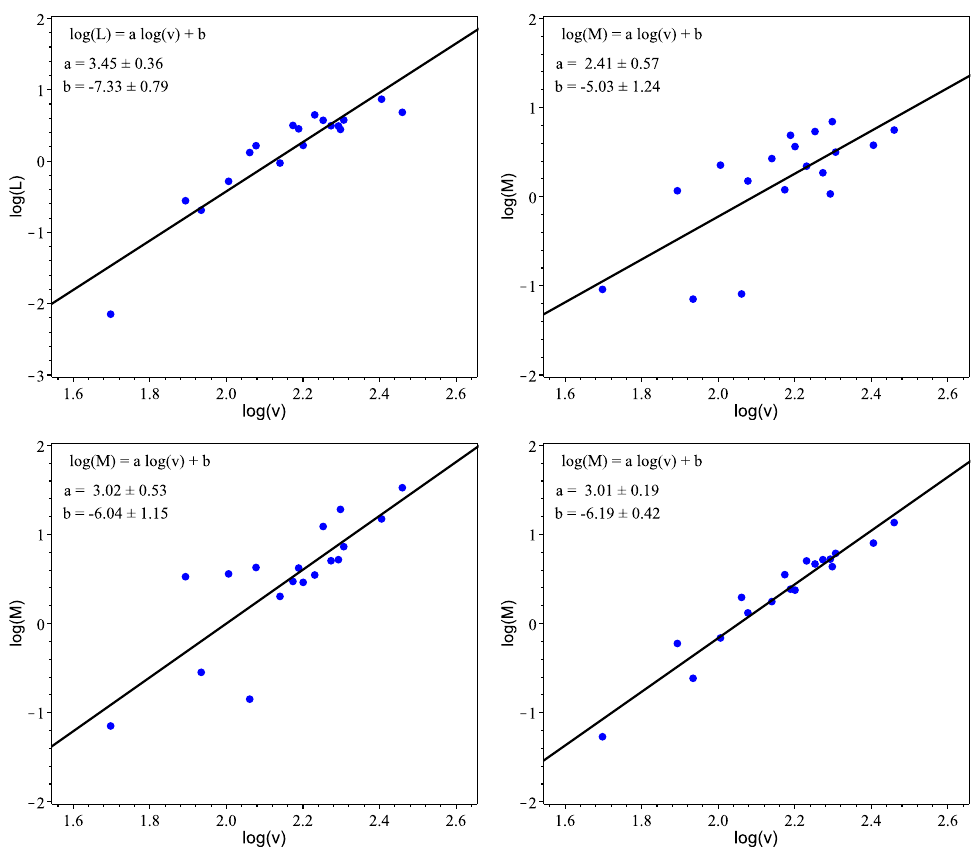
Figure 4. (color online) The Tully-Fisher relation. Left-top panel: the observed B-band Tully-Fisher relation. Vertical axis gives the base 10 logarithm of the observed luminosity (in units of 10 10 L (cid:12) , respectively 10 10 M (cid:12) ) and the horizontal axis is the base 10 logarithm of the last observed velocity (in km/s). Left-bottom panel: best fit Tully-Fisher relation parameterized by log ( M ) = a log ( v ) + b in the case of MOND. Right-top panel: Tully-Fisher best fit for the masses resulted from the parametric model given by Equation (17) using the mass distribution (7), respectively. Right-bottom panel: Tully-Fisher relation obtained using the spherical version of the exponential disk mass distribution (21). The value of M used in the plots is the total mass of a given galaxy: M = M ∗ + M gas